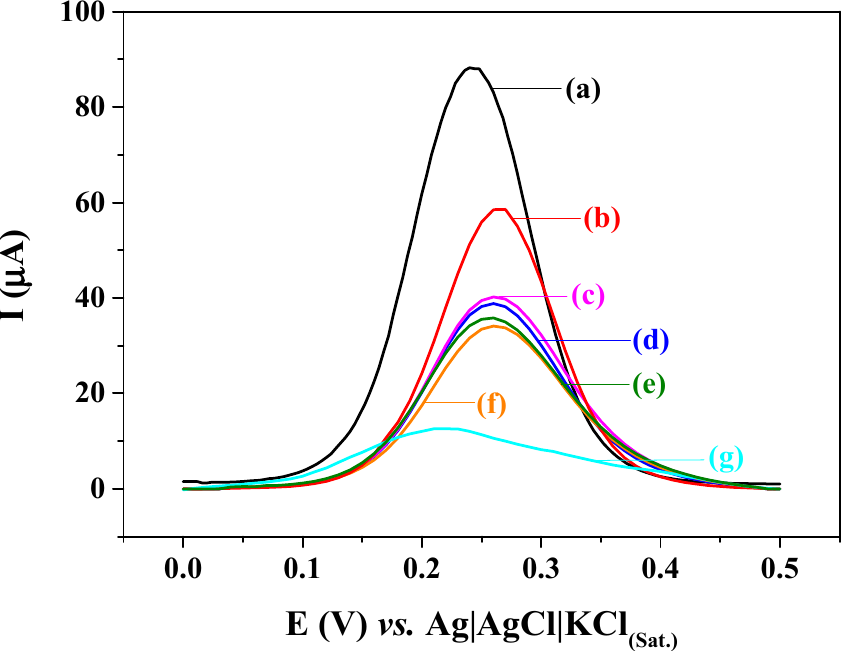
Figure 5. Square wave voltammograms for each step of the immunosensor assembly procedure: ( a ) bare GCE; ( b ) GCE/COOH-PPy; ( c ) GCE/COOH-PPy/NH 2 –NCY; ( d )